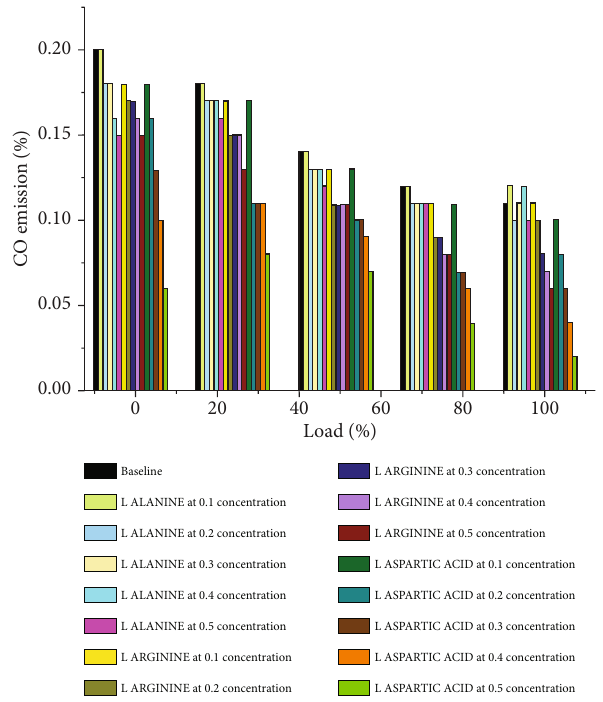
Figure 11: The di ff erence in carbon monoxide with respect to engine load.